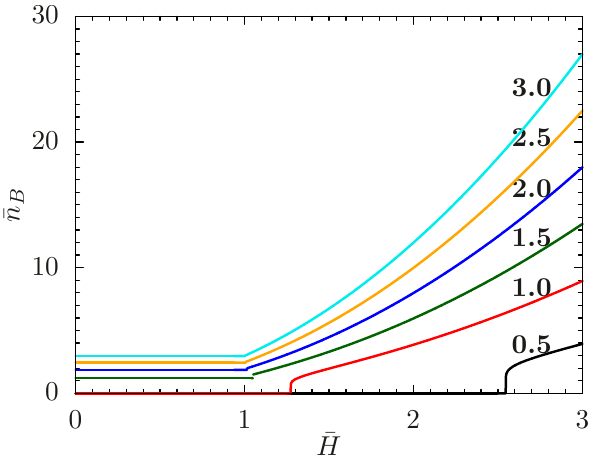
Figure 2 . Spatially averaged baryon number density in the ground state as a function of magnetic (cid:12)eld for several di(cid:11)erent values of the dimensionless chemical potential x (indicated in bold). The (cid:12)rst-order phase transition from the BEC to the CSL phase for x > 1 is visible in the